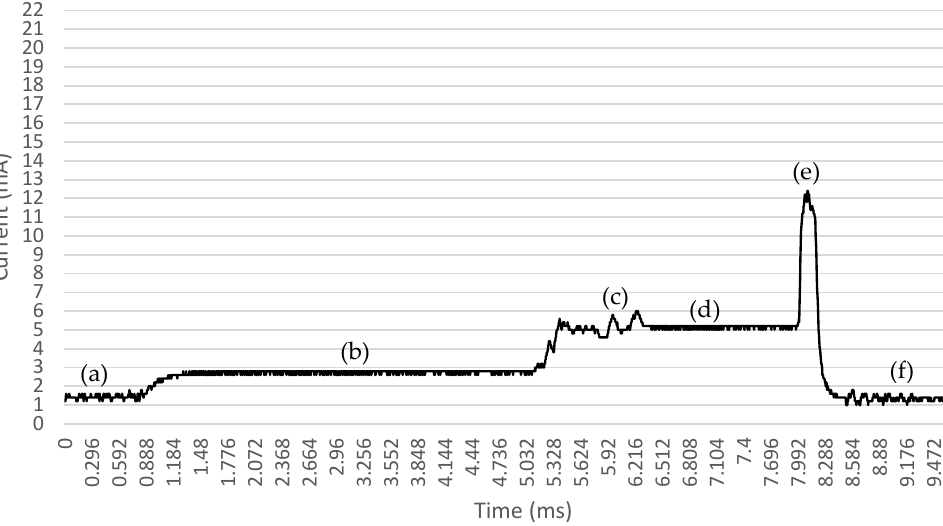
Figure 1. Current profile of the wearable over the inertial measurement unit (IMU) interrupt service routine (ISR). (a) is the idle current with IMU always on (1.2 mA); point (b) is where the system on chip (SoC) wakes up to process the ISR (2.8 mA). Then, the SoC enables the high-frequency clock; point (c) is where the SoC reads the IMU data over the SPI bus, and point (d) is where the IMU data is post-processed (5.2 mA); point (e) is where the IMU data is stored in the FLASH memory using a page write process (12.4 mA); and point (f) is where SoC then returns to idle with just the IMU running.